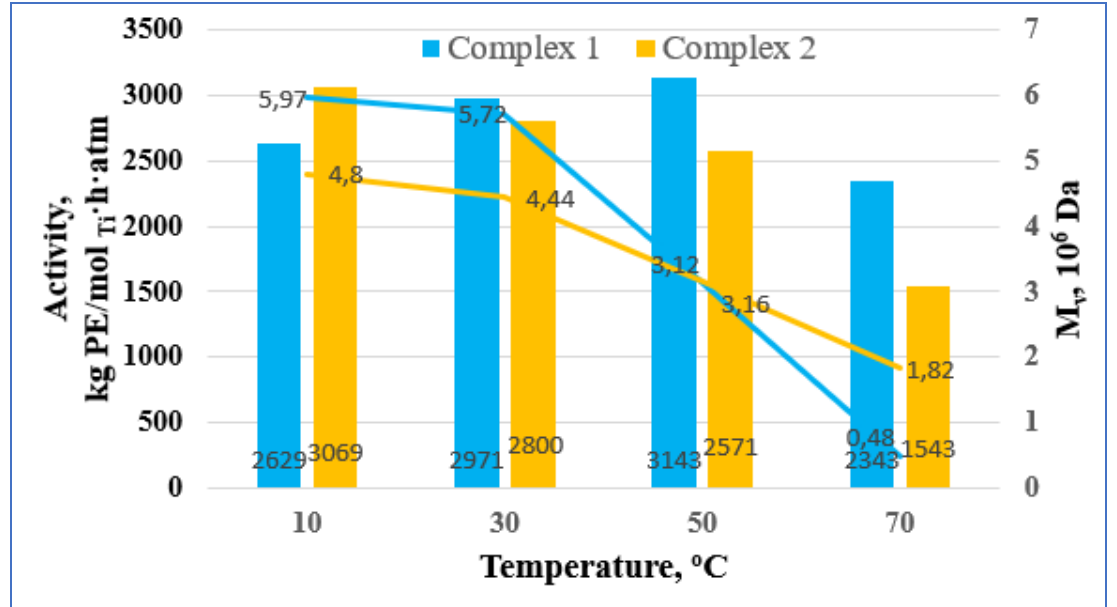
Figure 2. Influence of polymerization temperature on productivity of catalytic systems and polymer M v .